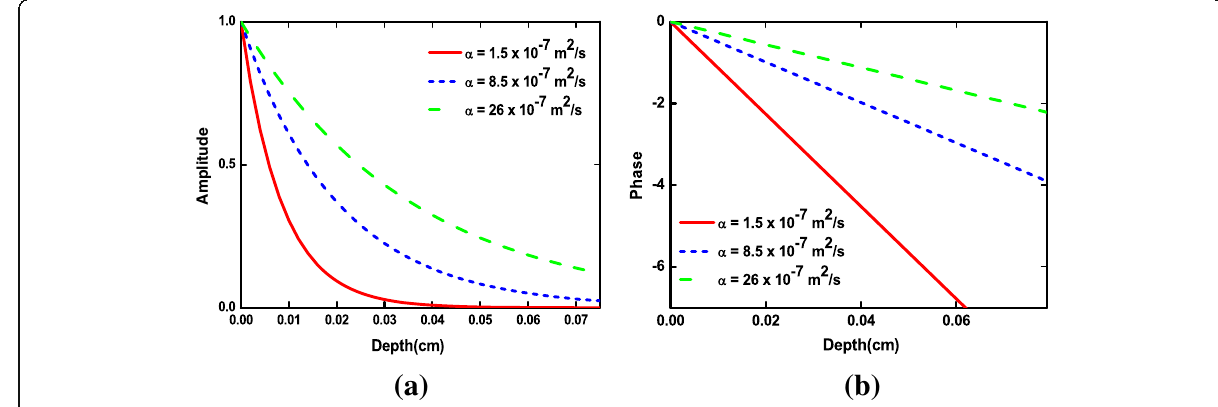
Fig. 2 a Amplitude and b phase of Eq. (5) with thermal diffusivity α as a